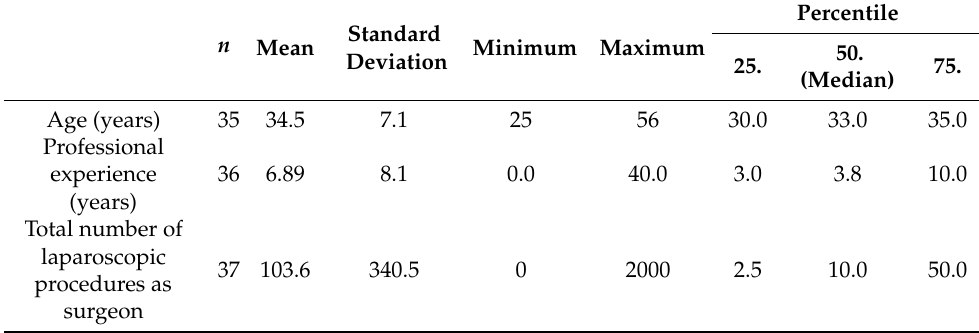
Table 2. Sociodemographic data and laparoscopic